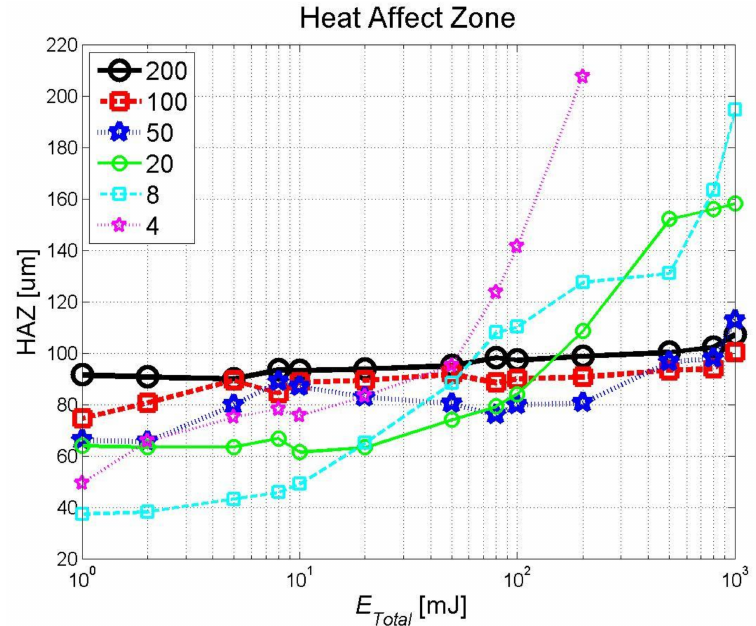
Figure 4. Heat affect zone (HAZ) with the pulse duration from 4 ns to 200 ns. The HAZ of the long pulses ( ∆ t = 50, 100, 200 ns) increase steadily with little deviation as E Total increases. On the other hand, the short pulses ( ∆ t = 4, 8, 20 ns) have a large deviation of hole sizes and the sizes rise sharply as E Total increases.